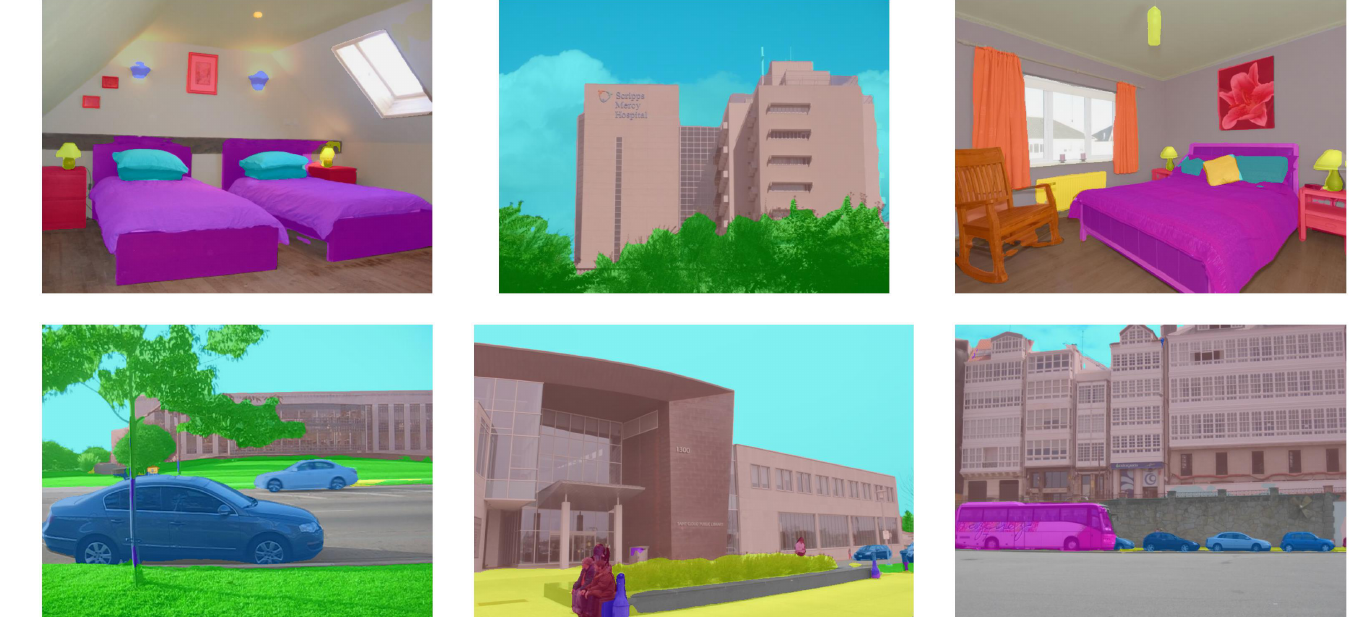
Figure A2. Examples of our PLG-ViT with UPerNet [58] on ADE20K